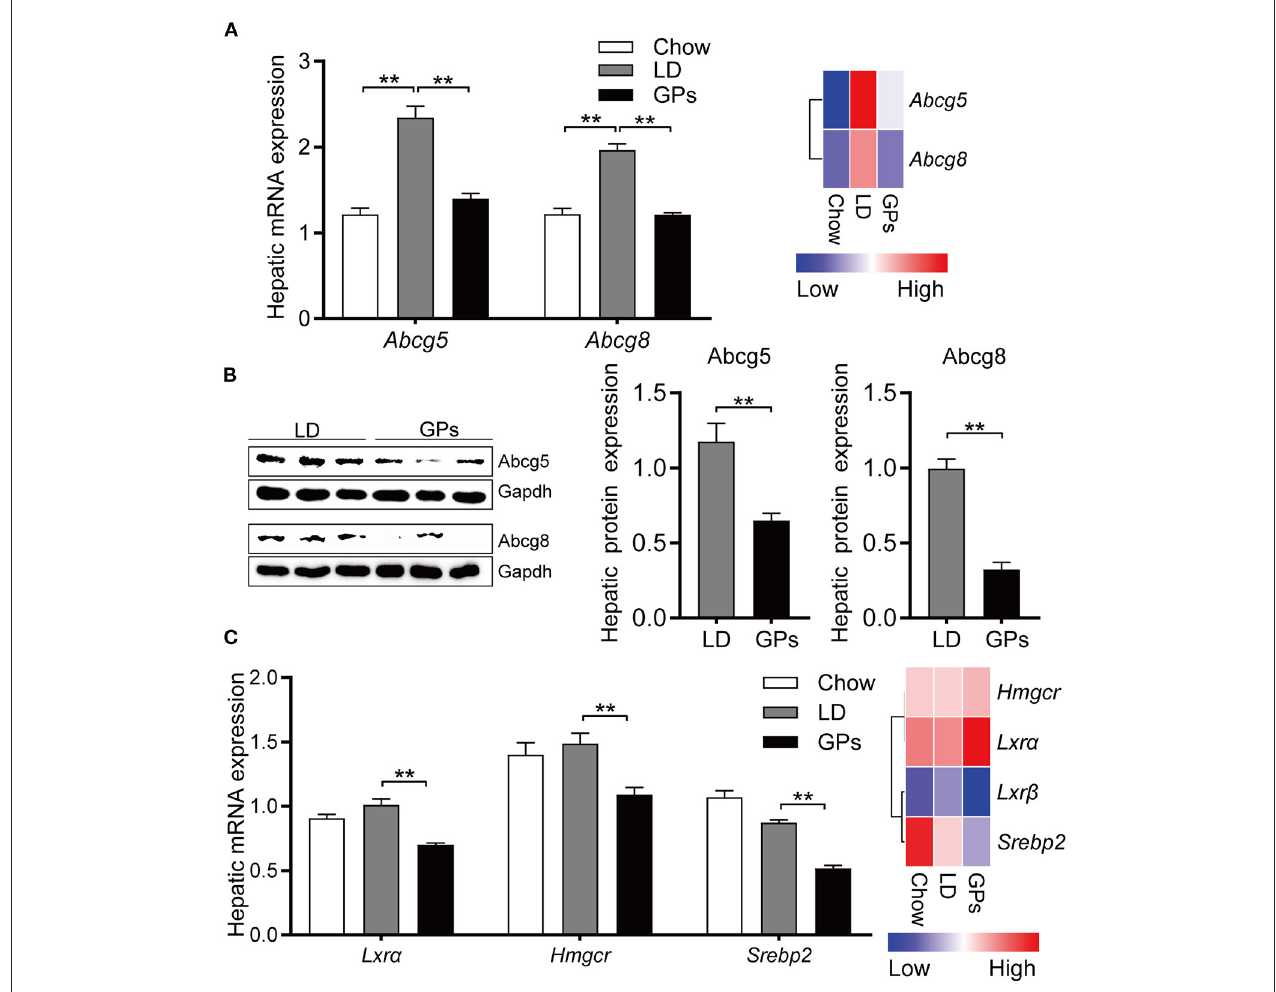
FIGURE 7 | Hepatic expression of genes involved in cholesterol transport and synthesis. (A) Levels of expression of Abcg5 and Abcg8 mRNAs measured by qRT-PCR (left panel, n = 8) and RNA sequencing (RNA-seq) analyses (right panel, data shown as means). (B) Protein expression and quantification of Abcg5 and Abcg8 ( n = 6). (C) Levels of expression of Lxr α , Hmgcr and Srebp2 mRNAs measured by qRT-PCR (left panel, n = 8) and RNA-seq analyses (right panel, data shown as means). Data are reported as means ± SEM. ** P <